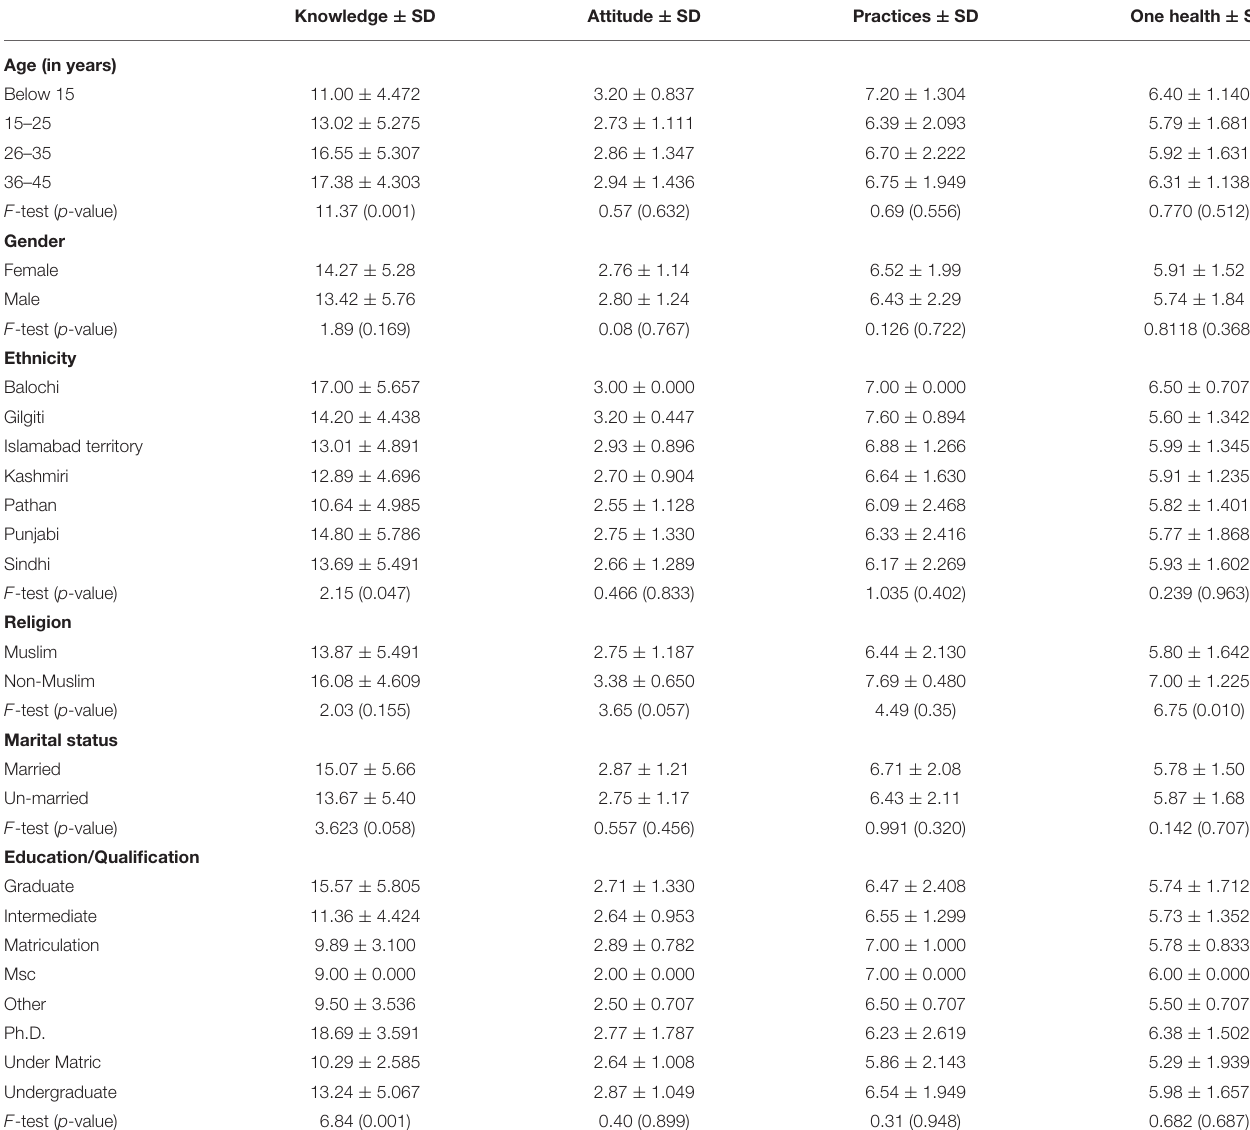
TABLE 6 | Demographic variables across KAPs and one health using